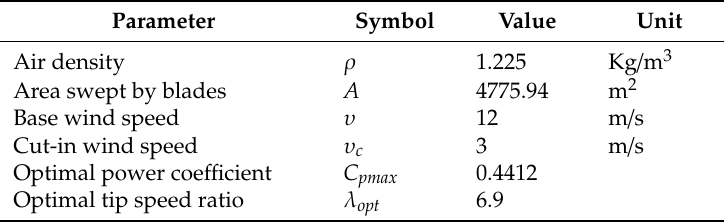
Table A2. Parameters of the turbine.